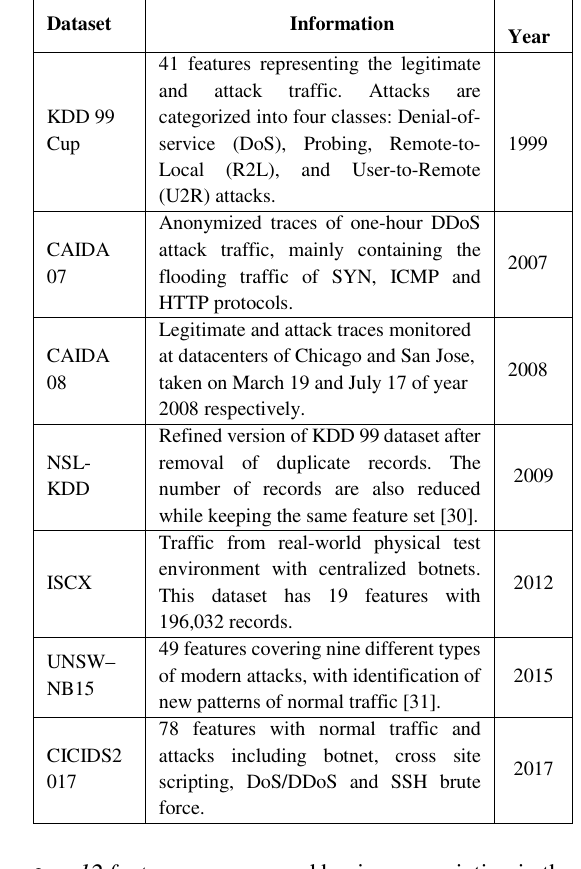
Table 1: Datasets for research on intrusion